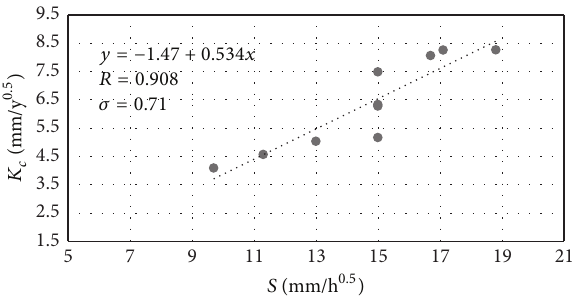
Figure 7: Carbonation versus sorptivity.